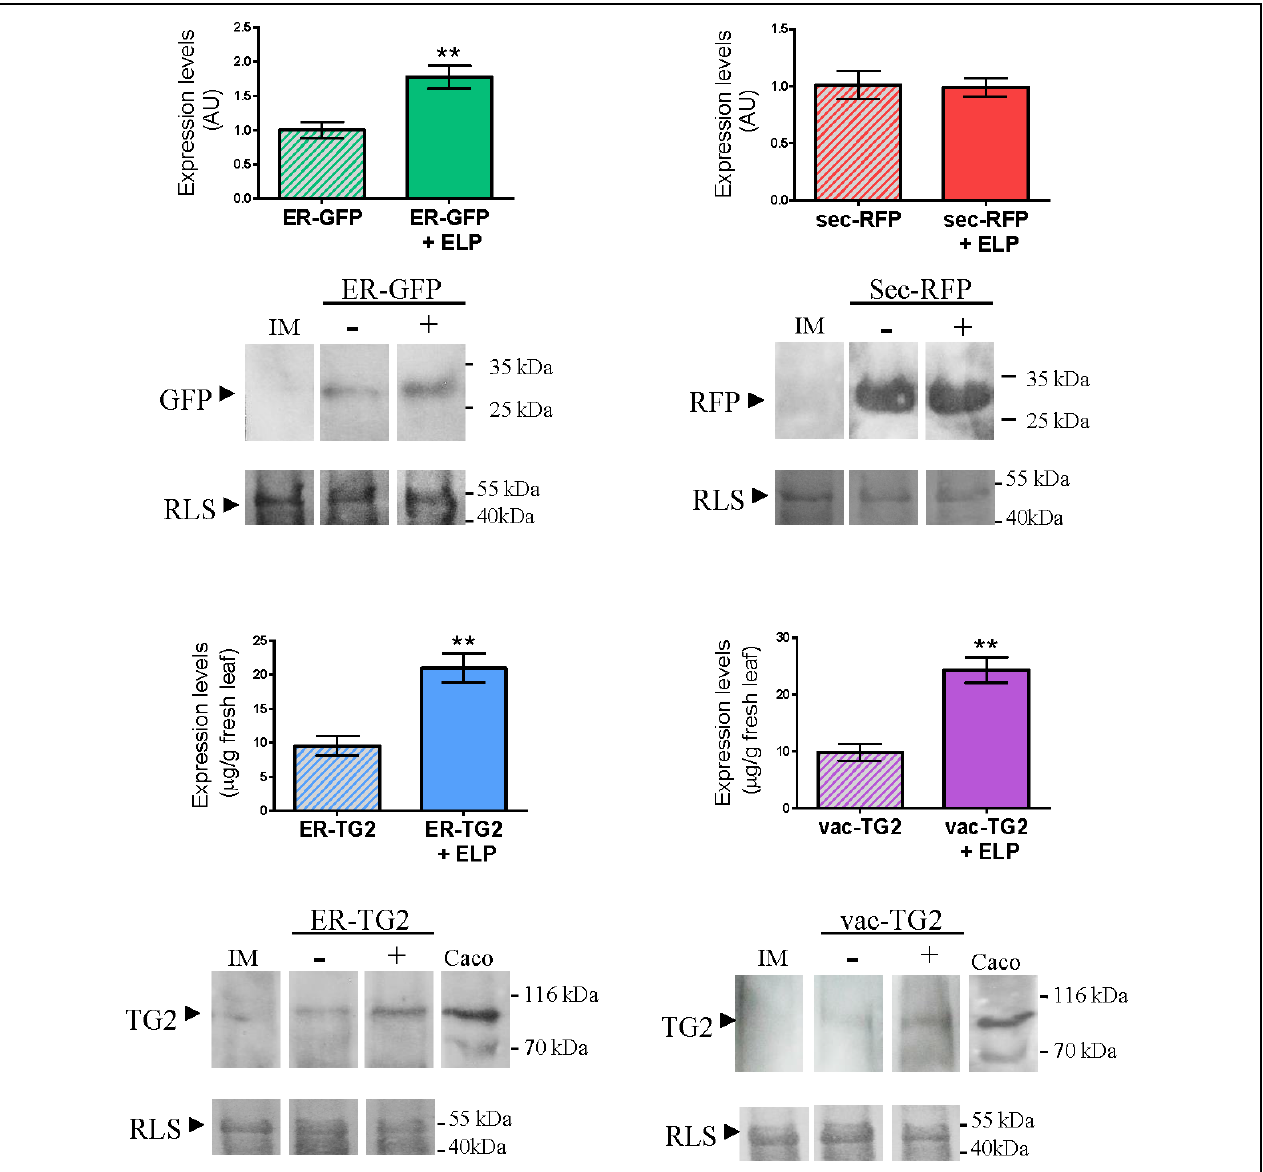
FIGURE 3 | Effect of ELP on the accumulation levels of ER-GFP, sec-RFP and ER-TG2 and vac-TG2. The same amount of total extract was loaded on the gel as can be observed by the amount of RLS stained with Coomassie Brilliant Blue R-250. The immunoblot was developed with anti-GFP, anti-RFP, and anti-TG2 mAb 2G3, for ER-GFP, sec-RFP and ER-TG2, and vac-TG2, respectively. The intensity of the band was quantified by using ImageJ. Three biological independent experiments were performed and each replicate was obtained using leaves from five different plants. Error bars are standard error of the mean (SEM). ∗∗ Denotes statistically significant difference by Student’s t -test ( P <